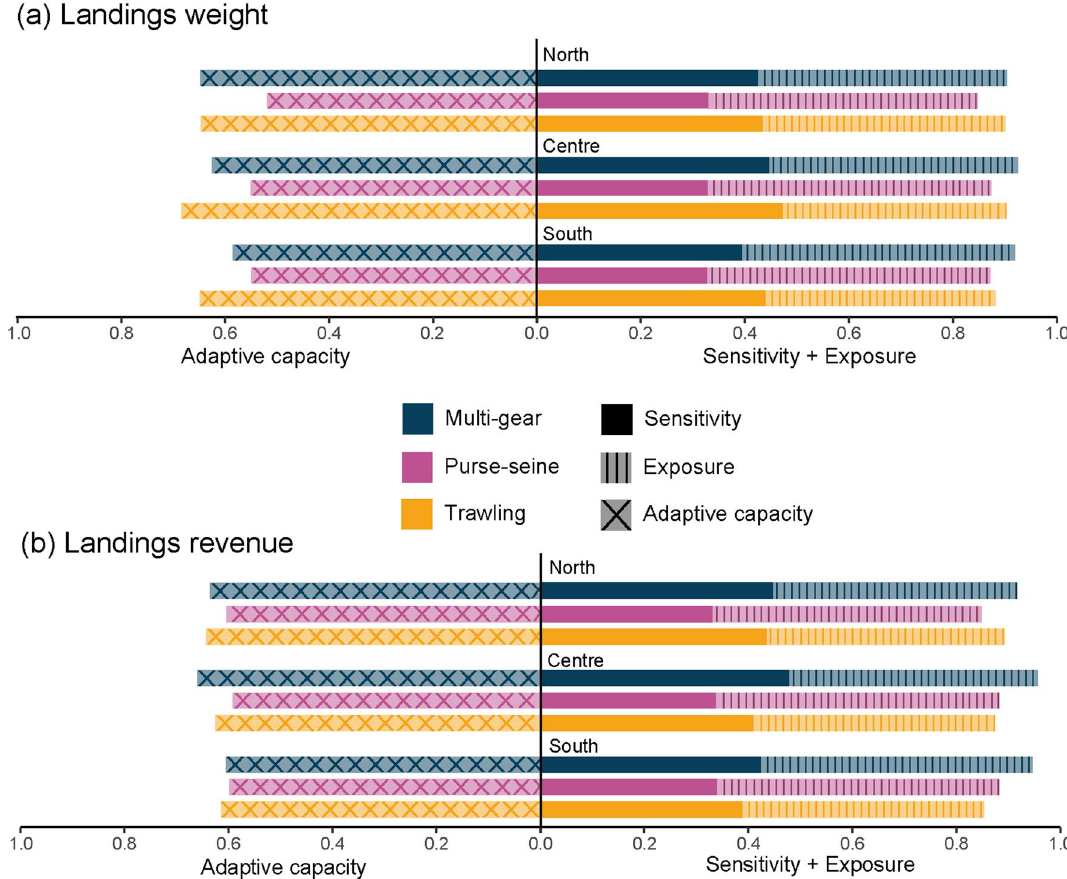
Figure 5. Values of the vulnerability components for the period 2010–2015 (sensitivity + exposure − adaptive capacity). Adpative capacity is represented in the left of the y axis, while sensitivity and exposure are represented in the right side of the y axis. Each component is represented with a different texture. All components are represented by gear type (colour) and area (north, centre and south). For exposure values correspond to the RCP 8.5. In the top panel the components in terms of landings weight are represented ( a ) and in the bottom panel the components in terms landings economic reveue are represented ( b The species that contributed the most to the EVL (€) in the purse-seine fleet was S. pilchardus . The proportion of contribution of S. pilchardus in EVL (€) increased in comparison to the contribution to landing weights, due to the higher average price of S. pilchardus (1.57 €·Kg −1 ) compared to S. colias (0.29 €·Kg −1 ). Dissimilarities in EVL (€) of purse-seine fleets were low between areas, and S. colias contributed the most (Supplementary Table S4 online). Similar to multi-gear and purse-seine fleets, the trawling fleets EVL (€) presented differences across areas. While in the north, T. trachurus was the main species, in the centre and south area, P. longirostris and N. norvegicus contributed the most to the EVL (€), due to their high average price (15.66 €·Kg −1 and 15.33 €·Kg −1 , respectively) (Fig. 4D). M. poutassou showed a low contribution in terms of economic revenue due to its low average price (0.57 € Kg −1 ) . High dissimilarity in EVL (€) was observed between the north and the two other areas, whereas the dissimilarity between the centre and south areas was low (Supplementary Table S6 online). The sensitivity, exposure and adaptive components of the EVL (€) (Fig. 5b) showed patterns different from those calculated in terms of EVL (Kg) . The sensitivity of multi-gear landings revenue was higher in the centre and south area, whereas in the north, multi-gear and trawling presented similar sensitivity values. Purse-seine landings revenue presented the lower sensitivity values in the three areas. For exposure, purse-seiner landings revenue had the highest values among the three areas. The ecological adaptive capacity of multi-gear and trawl- ing landings revenues were higher than in purse-seine fleets in the three areas, although differences in the south were minimal (Fig. 5b; Supplementary Table S6 online). Prioritization of species for management. In general, most of the species were in the lower-left of the prioritization plot (Fig. 6). Specifically, multi-gear fleets showed higher numbers of species with moderate vul- nerability, but with low dependence on them in the three areas (Fig. 6a, Supplementary Table S7 online). How- ever, for O. vulgaris in the north and centre areas the dependence was moderate and in the south the dependence was high, with more than 40% of the landings weights and revenues of multi-gear in the south being obtained from this species. In the centre area, the dependence on A. carbo was also classified as moderate.